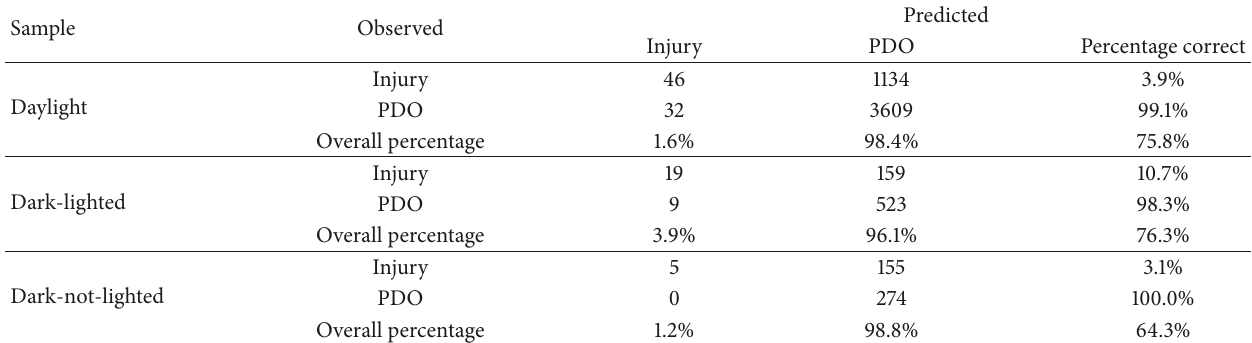
Table 6: Prediction